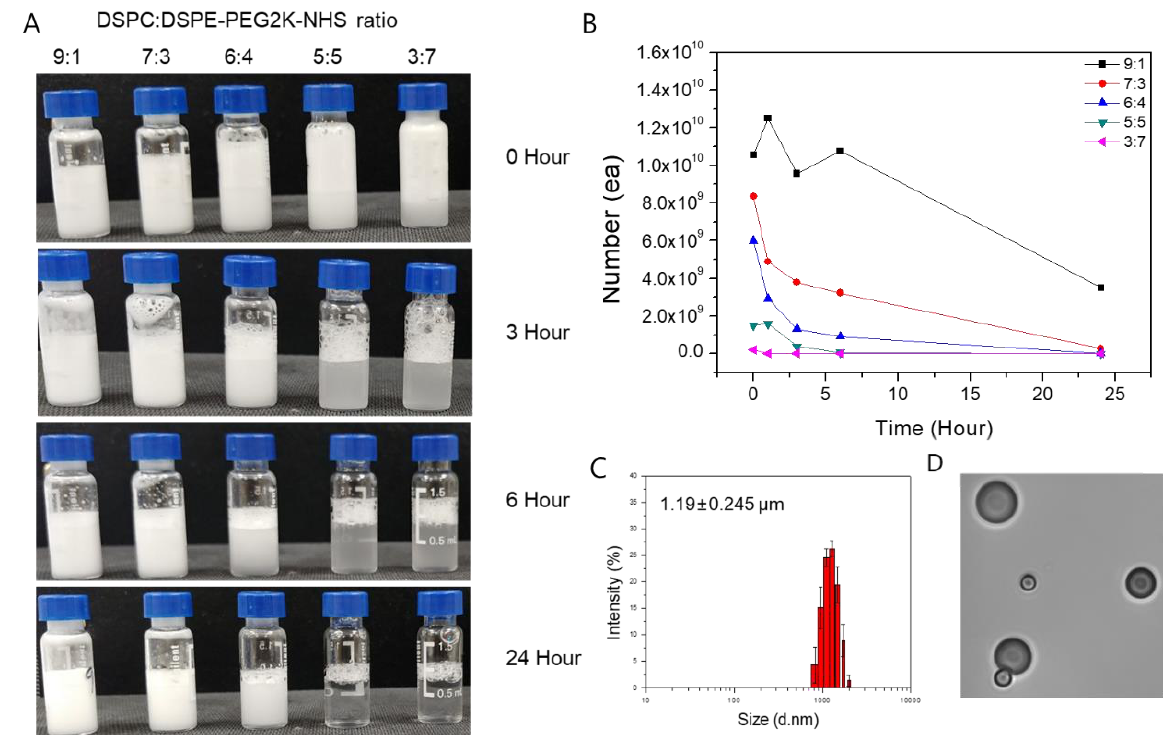
Figure 1. The yield, size, and stability of microbubbles (MBs) with different molar ratios of the phospholipids. ( A ) Synthe- sized MBs with various molar ratios of DSPC:DSPE-PEG2K-NHS. MBs with a higher DSPC ratio retain their structure for up to 24 h, while a higher ratio of DSPE-PEG2K leads to MB instability. ( B ) MBs were counted under the light microscope. Similar to the visual inspection, MBs with 9:1 DSPC:DSPE-PEG2K ratio had the highest count at the time of synthesis and 24 h post-synthesis. ( C ) The average size of the synthesized MBs with 9:1 DSPC:DSPE-PEG2K ratio was 1.19 ± 0.245 μm. ( D ) A picture of the MBs was taken under the light microscope.